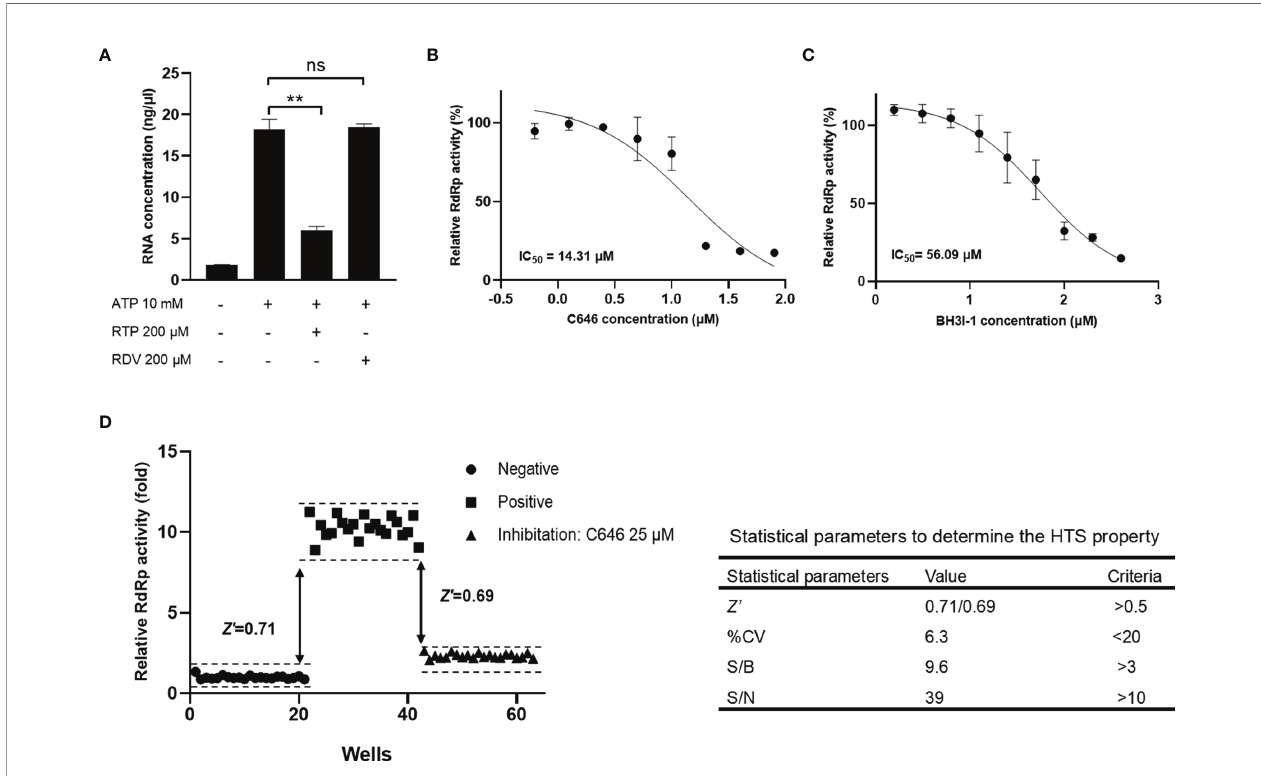
FIGURE 5 | Reliability and reproducibility of the fl uorometric SARS-CoV-2 RdRp activity assay system in HTS. The inhibition of remdesivir, triphosphate remdesivir (A) , C646 (B) , and BH3I1 (C) on SARS-CoV-2 RdRp activity in fl uorometric RdRp activity assay. The data were presented as the mean ± SEM. Statistical signi fi cance was analyzed using one-tailed Student ’ s t -test and non-linear regression analysis of IC 50 was conducted using GraphPad Prism ® Software V.8.0 for Windows (GraphPad Software Inc., San Diego, CA, USA). ** p < 0.01; ns, no signi fi cance. The data are representative of at least three independent experiments. (D) Validation of the accuracy of the fl uorometric SARS-CoV-2 RdRp activity assay as a high-throughput screening system. Z -factor was calculated using the relative RdRp activity obtained from the negative and positive groups to evaluate the discriminant ability of the assay for RdRp activity. Z ’ -factor was calculated using data obtained from the positive inhibitor group to evaluate the applicability of C646 as a positive control for the HTS